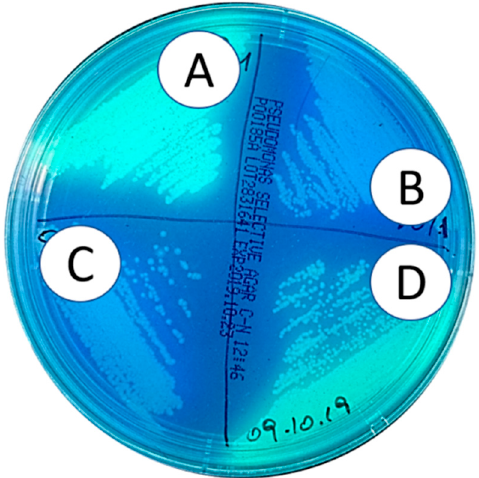
Figure 5. Fluorescence image of colonies of 5 × 10 6 cells / mL ( A , D ) and 2.5 × 10 6 cells / mL ( B , C ) P. aeruginosa , plated after 20 days of incubation in coupon-free